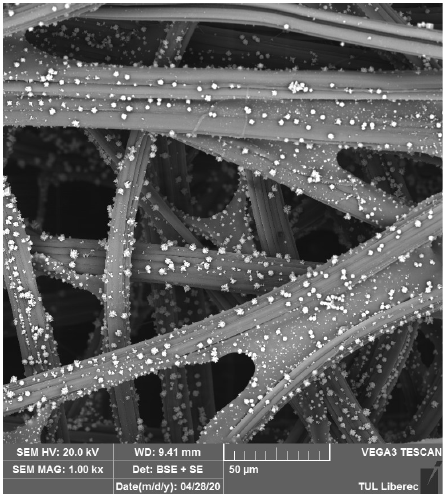
Figure 7. Deposition of Cu 2 O on the surface of viscose fabric.